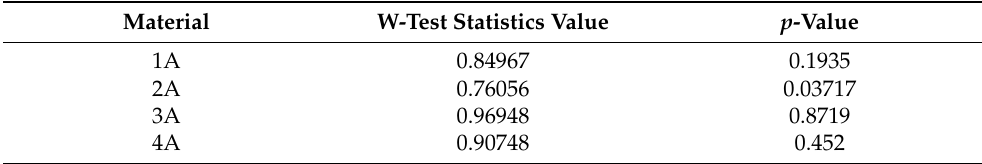
Table 10. S-W test results for individual materials.